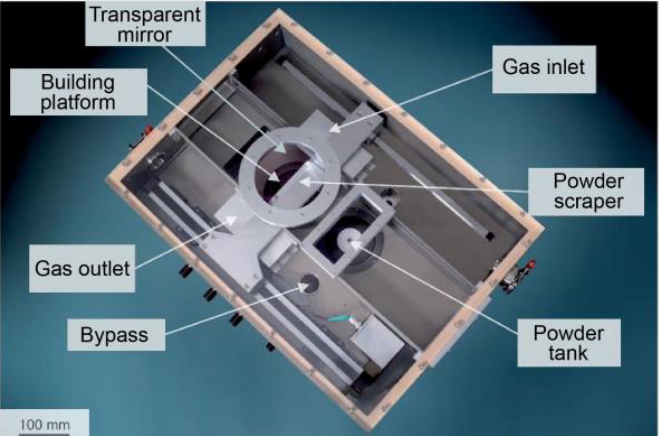
Figure 1. LPBF processing chamber with customized gas circulation system.